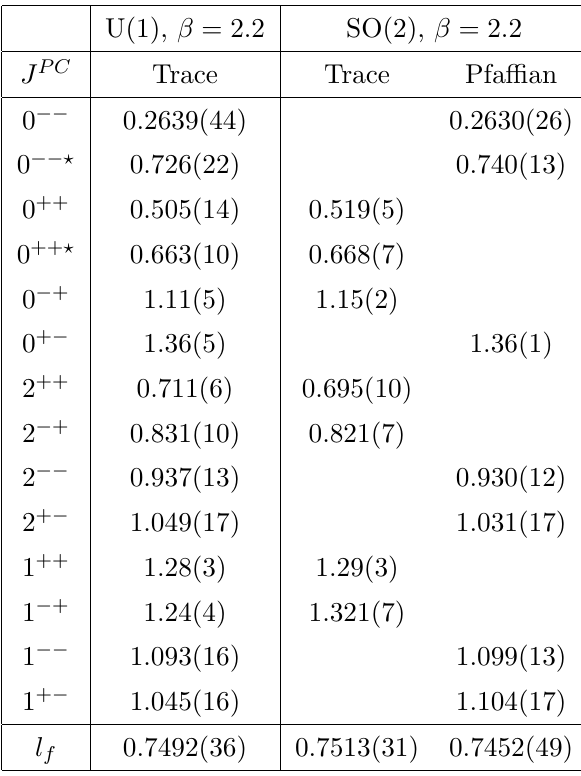
Table 1 . Lightest glueball masses in U(1) and SO(2) on a 28 2 36 lattice at a coupling (cid:12) = 2 : 2 for various spins J and parity P . For U(1) also labelled by charge conjugation C , and for SO(2) in the two sectors indicated as explained in text. Also shown is the energy of the lightest fundamental (cid:13)ux tube, l f , winding around a periodic spatial